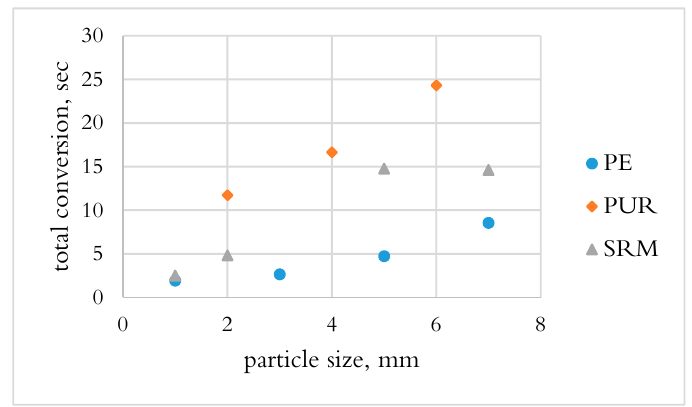
Figure 6. Total conversion times for the tested materials at different particle sizes.